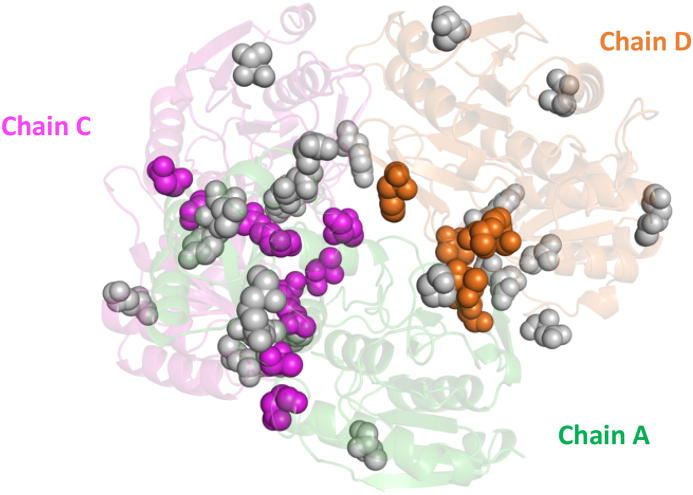
Projection on the crystal structure of the L-asparaginase II residues used to generate AIRs in the docking calculation. The residues making inter-monomeric contacts are shown as colored spheres (A–C interface in purple; A–D interface in orange). (For interpretation of the references to colour in this figure legend, the reader is referred to the web version of this article.)